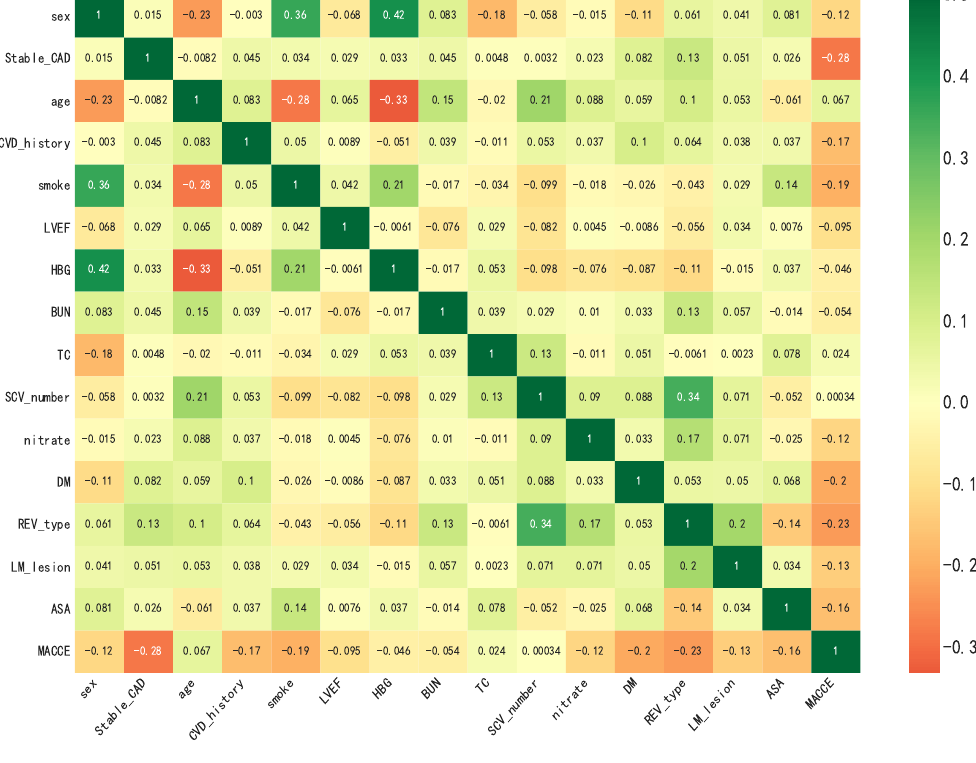
Figure 3. The correlation matrix of features.